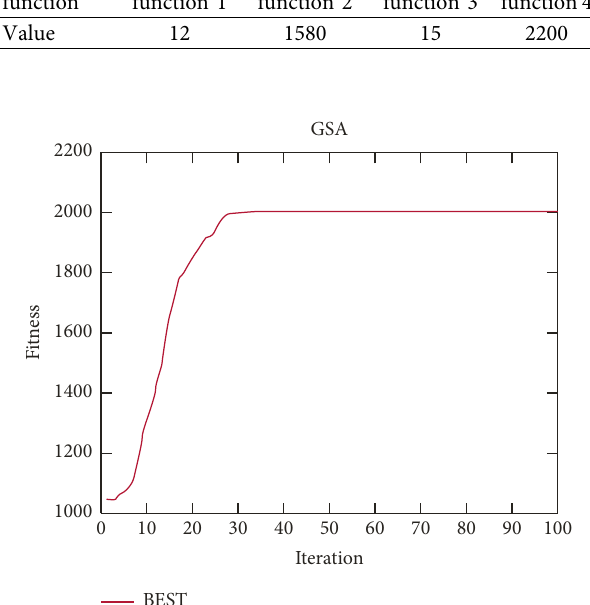
Table 4: Optimal value of Y